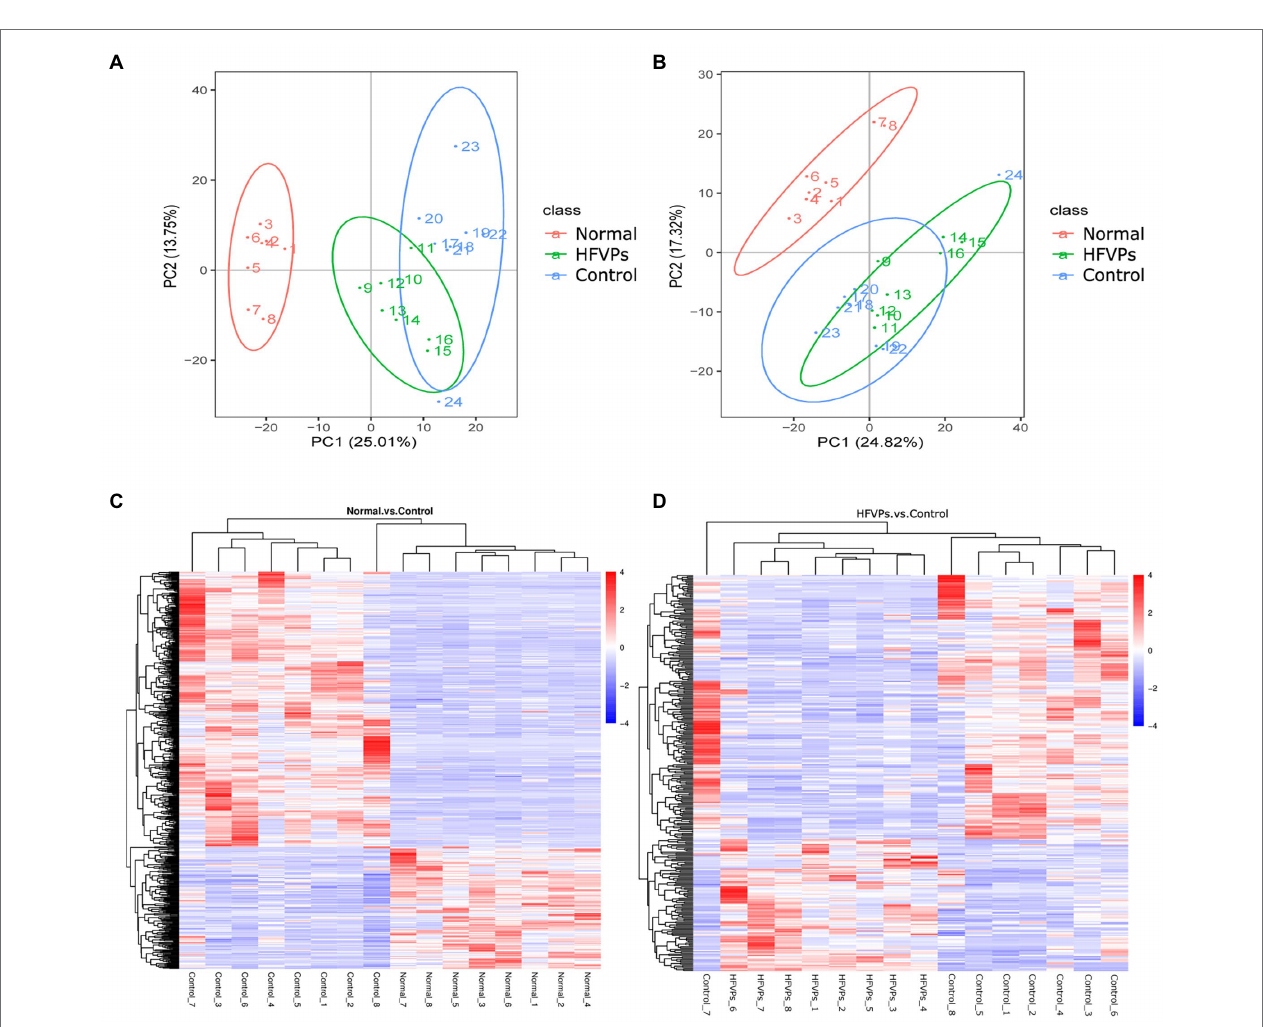
FIGURE 7 | (A) Principle coordinate analysis plots of the fecal metabolites in the Control, Normal, and HFVPs groups in positive mode. (B) PCA plots of the fecal metabolites in the Control, Normal, and HFVPs groups in negative mode. (C) Hierarchical clustering plots of the significantly changed metabolites in the Control and Normal groups. (D) Hierarchical clustering plots of the significantly changed metabolites in the Control and HFVPs groups.